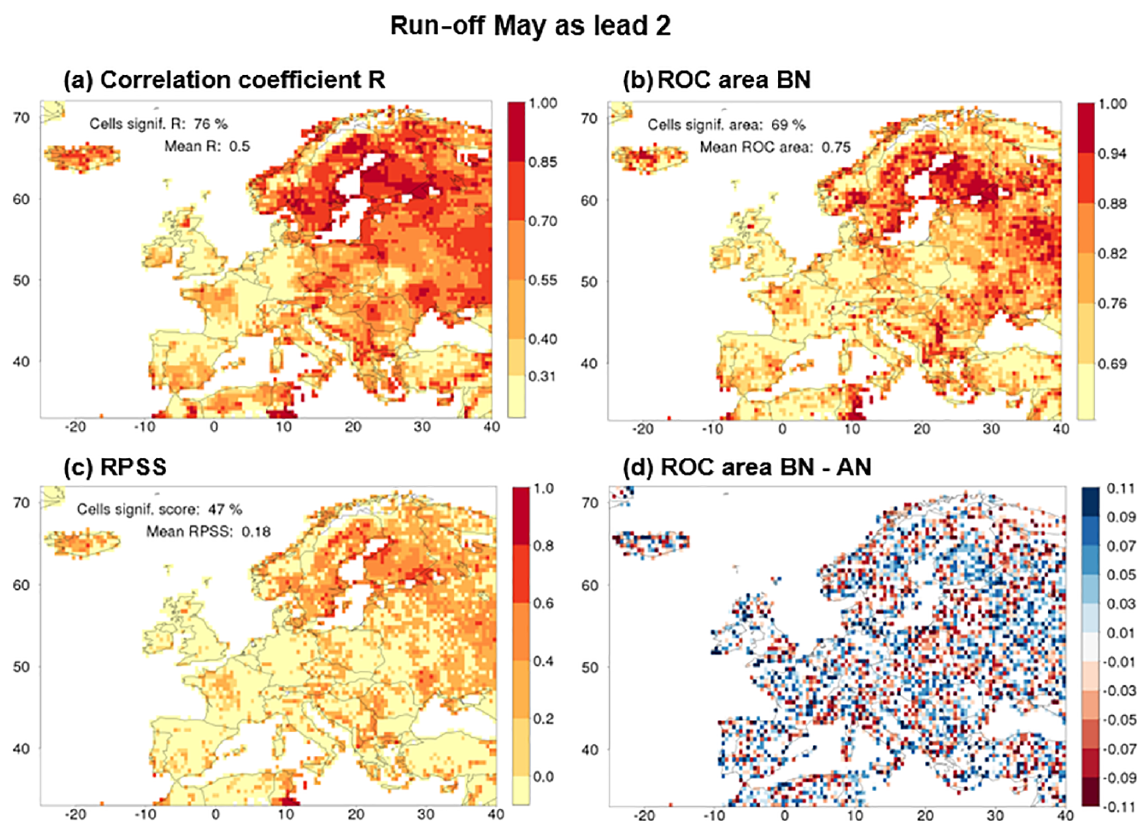
Figure 9. Maps of different skill metrics for one combination of a target month (May) and a lead month (2) of the run-off hindcasts. Panels show (a) R , (b) the ROC area for the below-normal tercile, (c) the ranked probability skill score (RPSS) and (d) the difference in ROC area between the BN and AN terciles. (a, b, c) skill is not significant in cells with a yellow colour. Legends provide the fraction of cells with significant values of the metric and the domain-averaged value of the